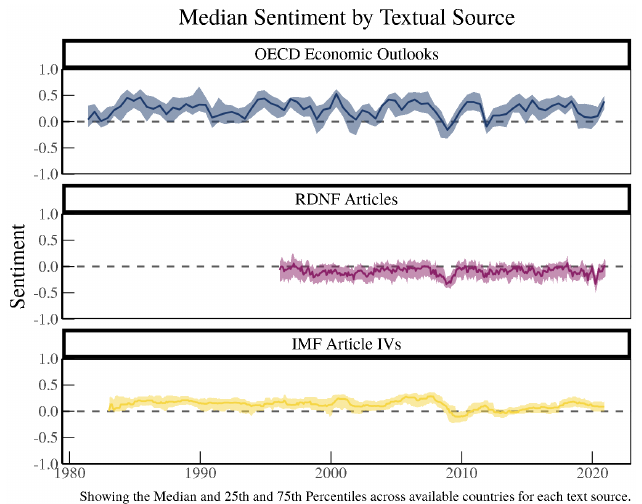
Figure 4. Median Sentiment Scores Using Different Texts . Note: This figure shows Correa et al. (2017) Financial stability (FS) sentiment scores for OECD Economic Outlooks, RDNF Articles,